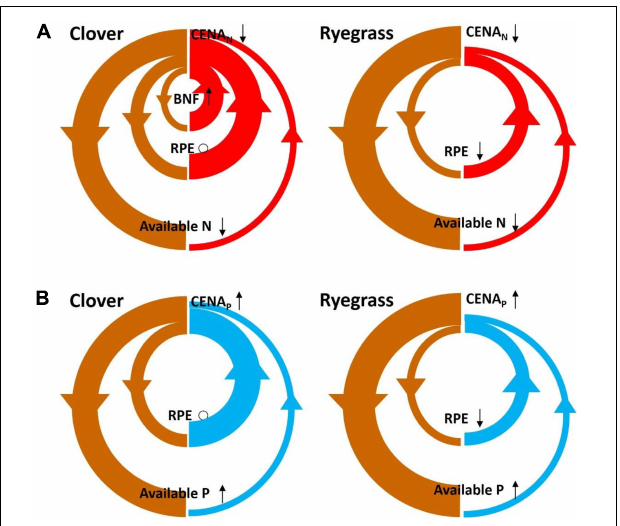
FIGURE 3 | Schematic framework showing how belowground C efficiency for N acquisition (CENA N ) (A) and for P acquisition (CENA P ) (B) vary with soil P availability for clover and ryegrass. Brown arrows, carbon flows; red arrows, nitrogen flows; and blue arrows, phosphorus flows. Thickness of arrows indicates the relative importance of C, N, and P flows, while differences in thickness between carbon and nutrient flows indicate CENA (i.e., relatively thick carbon arrows compared to nutrient arrows indicate a low CENA and vice versa). BNF, biological N 2 fixation; RPE, rhizosphere priming effect. Black arrows and circles next to CENA N , CENA P , BNF, RPE, available N, and available P indicate effect of P fertilization (upward arrow, positive; downward arrow, negative; circle, and no effect). For clover, CENA N decreases with P fertilization because the negative effect of P fertilization on N availability outweighs the positive effect on